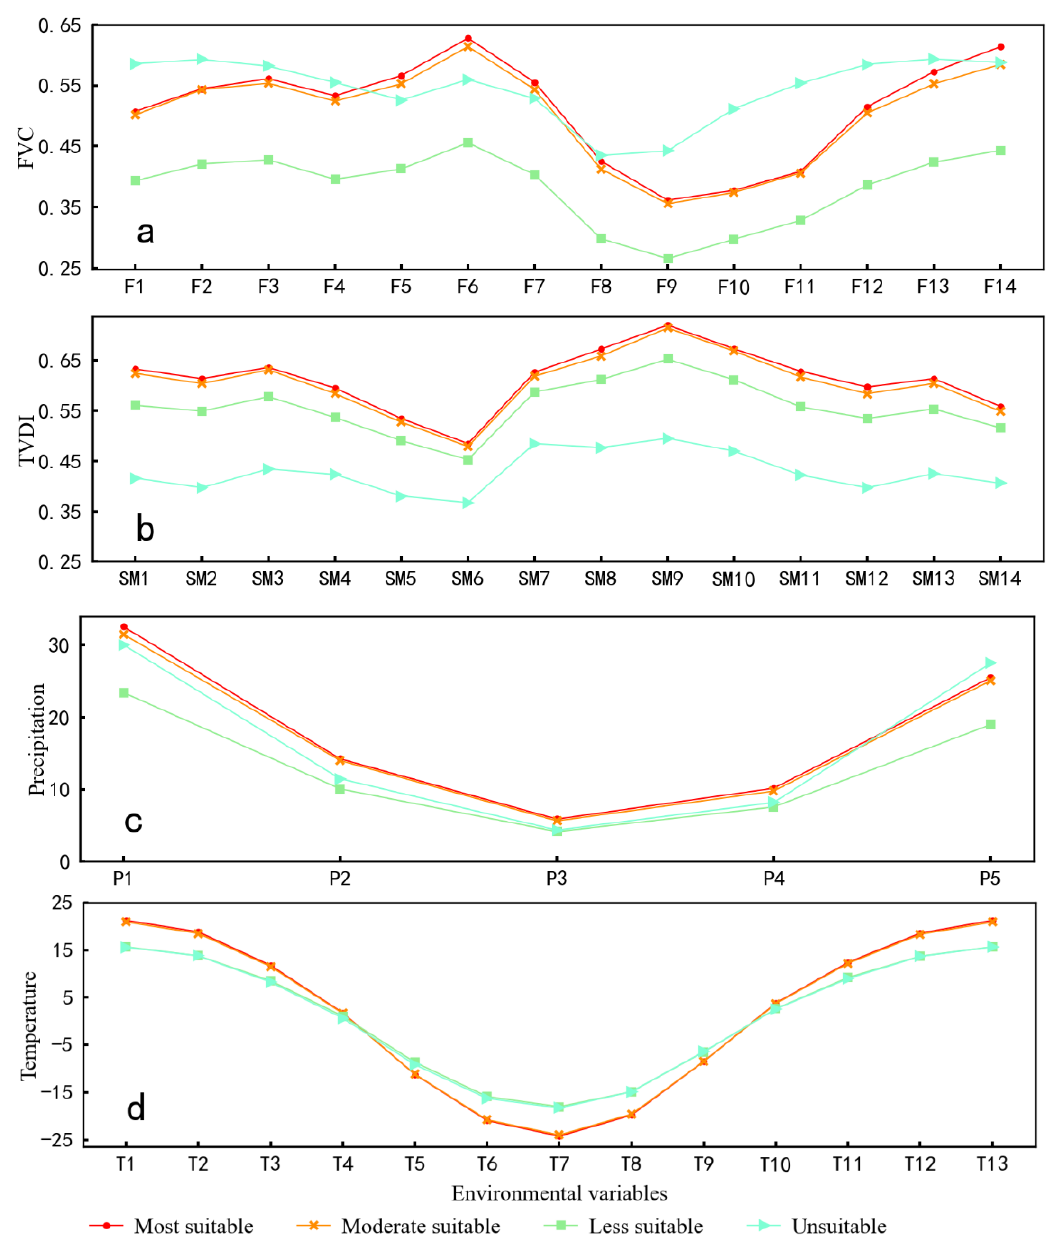
Figure 7. Differences in four eco-environmental variables during the grasshopper life cycle at different suitability levels, including the differences of FVC ( a ), TVDI ( b ), precipitation ( c ), and temperature ( d ). The diversity of FVC under the four levels of suitability is shown in Figure 7a. The values of F1, F2, and F6 in the spawning period, F9 and F10 in the incubation period, and